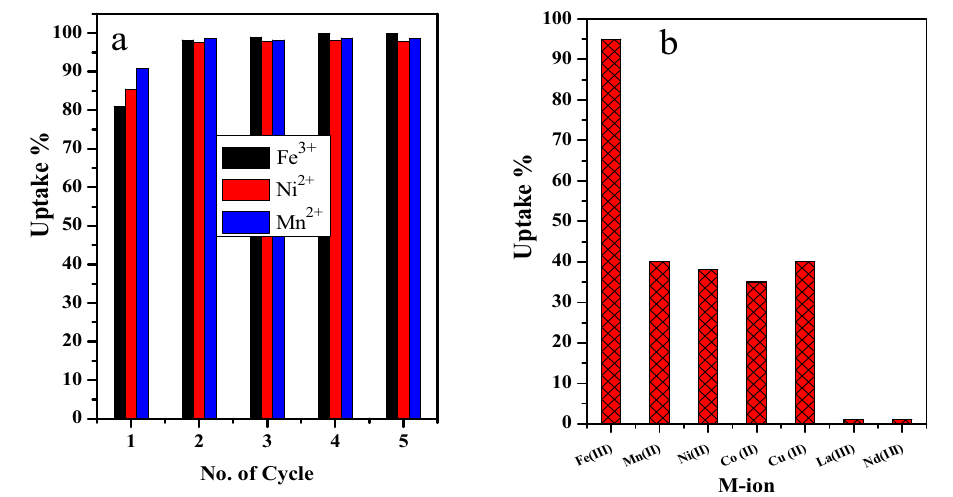
Figure 6. ( a ) The effect of the number of the re-use cycles of the GO-C on the uptake percentage of Fe 3+ (t = 1.0 min, [Fe] = 300 mg/L, Dose = 6 mg, V = 5.0 mL, pH = 2.5,T = 25 °C), Ni 2+ ([Ni] = 100 mg/L, Dose = 4.8 mg, V = 5.0 mL, pH = 8, T = 25 °C) and Mn 2+ ([Mn] = 100 mg /L, Dose = 4.8 mg, V = 5.0 mL, pH = 7, T = 25 °C) from aqueous media, and ( b ) removal of some heavy metal ions mixture from lanthanides solution. ([Fe 3+ ] = 300.0 mg/L; [Mn 2+ ] = 100.0 mg/L; [Ni 2+ ] = 100.0 mg/L; [Co 2+ ] = 100.0 mg/L; [Cu 2+ ] = 100.0 mg/L, [La 3+ ] = 100.0 mg/L; [Nd 3+ ] = 100.0 mg/L V = 10.0 mL, m = 0.024 g, pH = 2, Shaking time = 1.0 min, T = 25